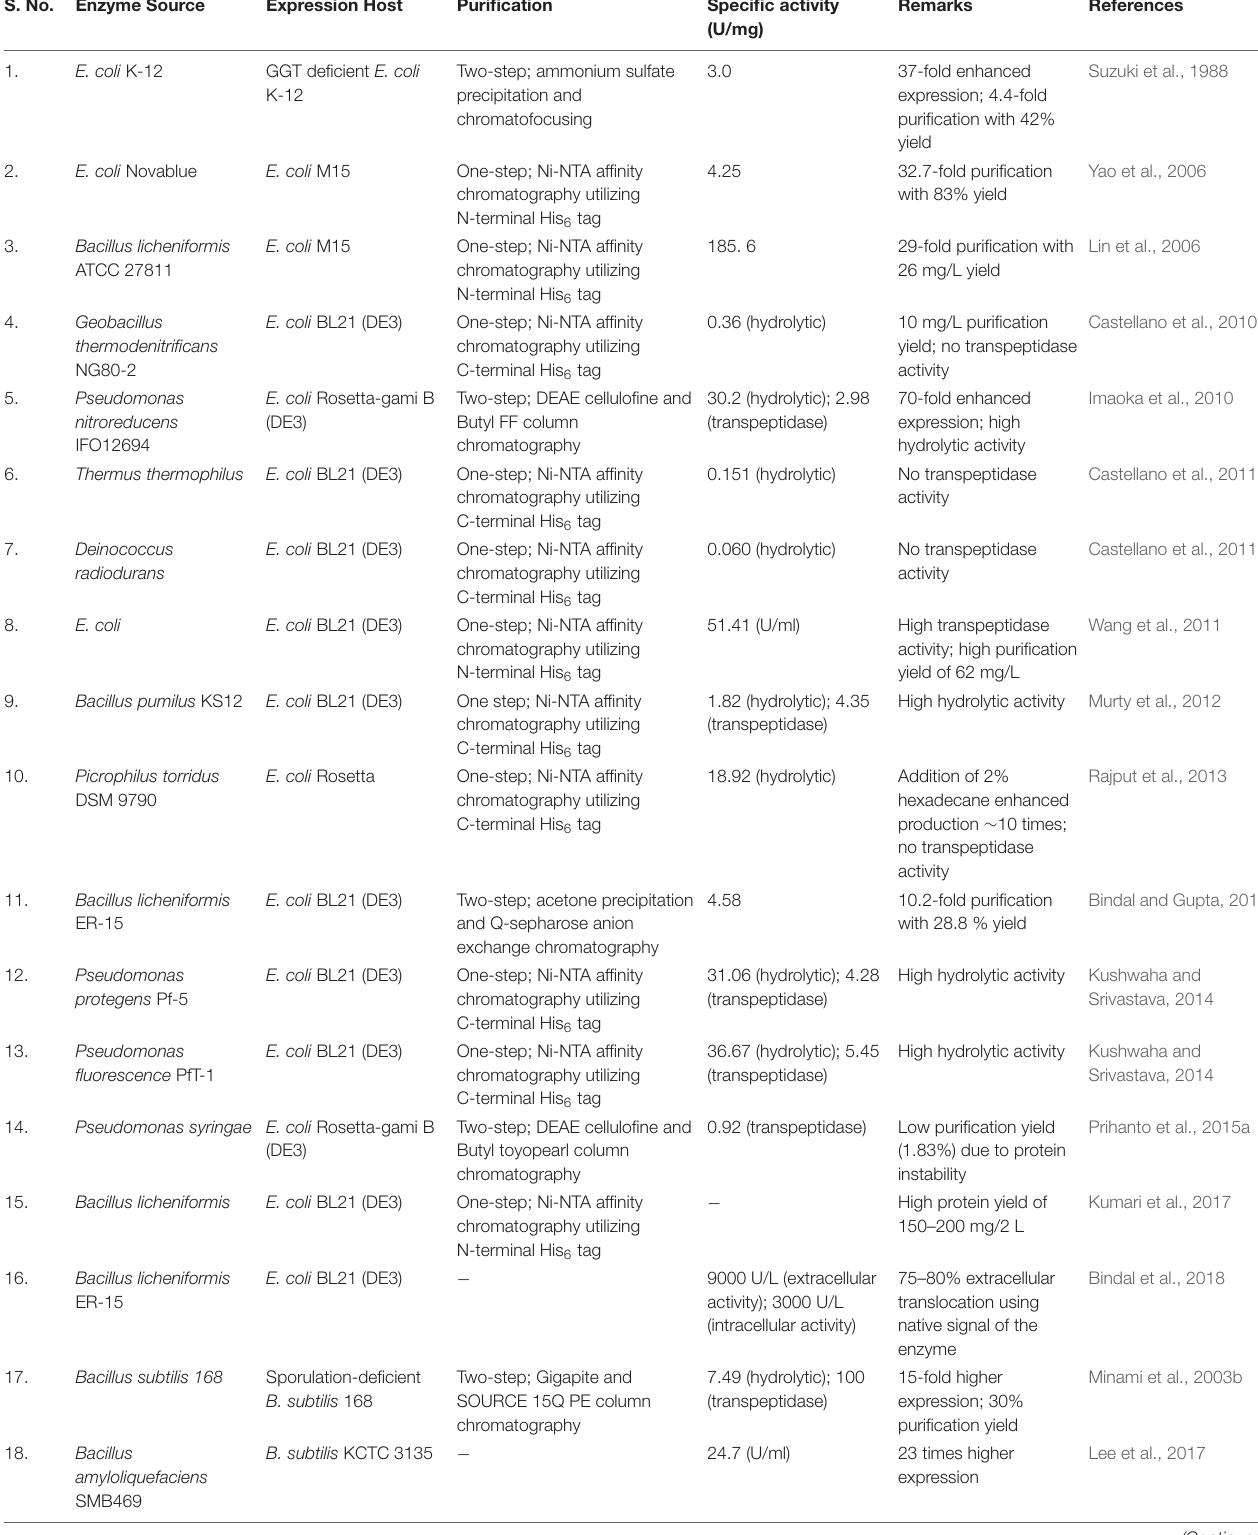
TABLE 4 | Heterologous expression of prokaryotic gamma-glutamyl transpeptidases (GGTs). S. No. Enzyme